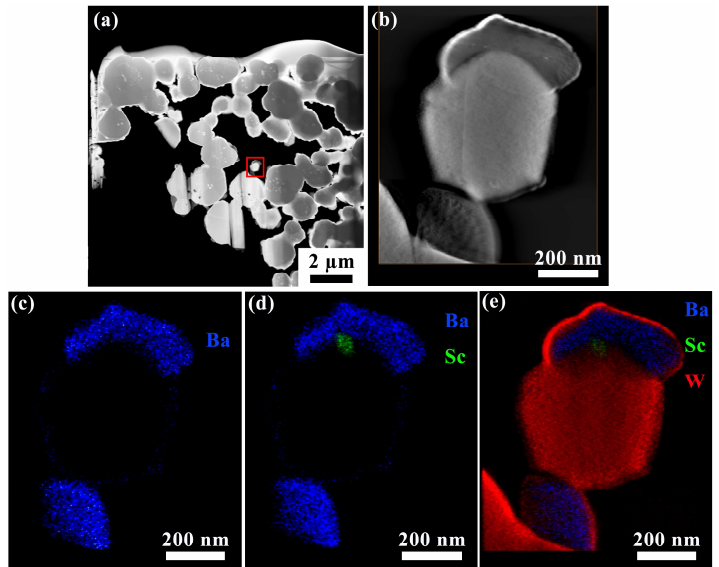
Figure 5. ( a ) HAADF image of near-surface cathode region where structure and elemental distribution were investigated by tomography. ( b – e ) HAADF image and EDS elemental maps, shown as 2D slices from the 3D tomogram, of a Ba–Al oxide particle that encases a smaller Sc-containing particle and sits on a W grain. Sc is distinct from both the W particle and the Ba–Al oxide.